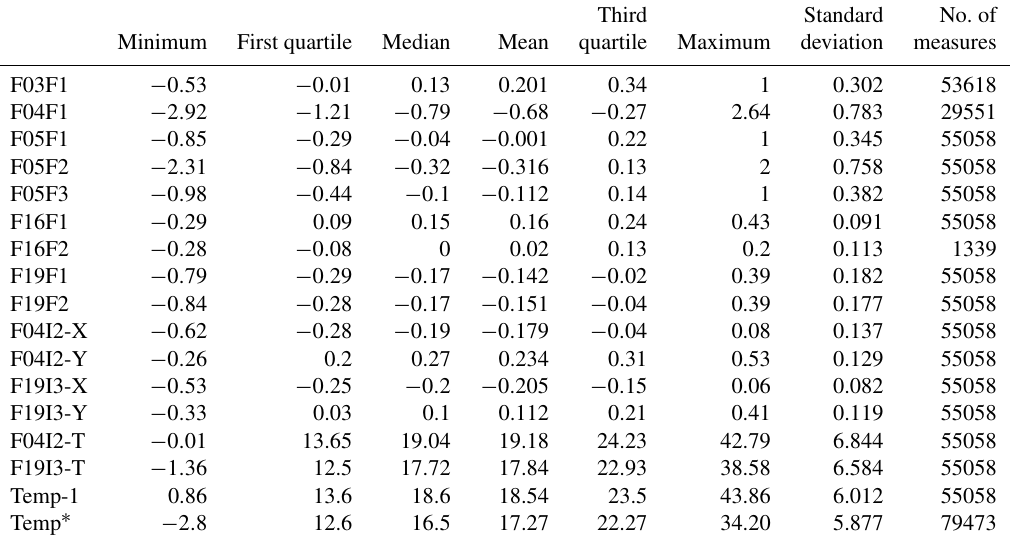
Table 6. Descriptive statistics of tuff deformation data and temperatures measured by